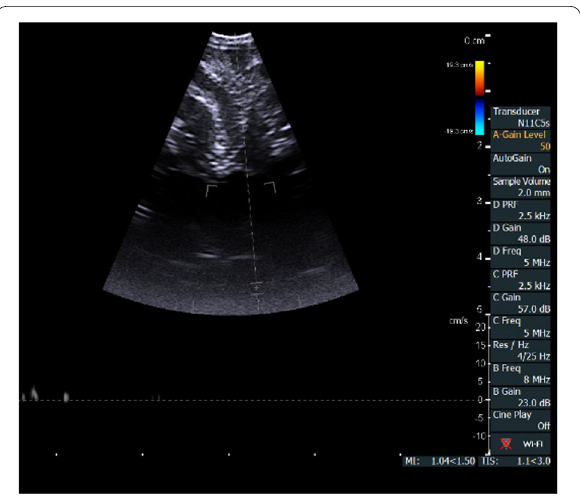
Fig. 13 IOUS of cavernoma case post‑excision after closure of the dura. Note: absence of the hyperechoic lesion (cavernoma)